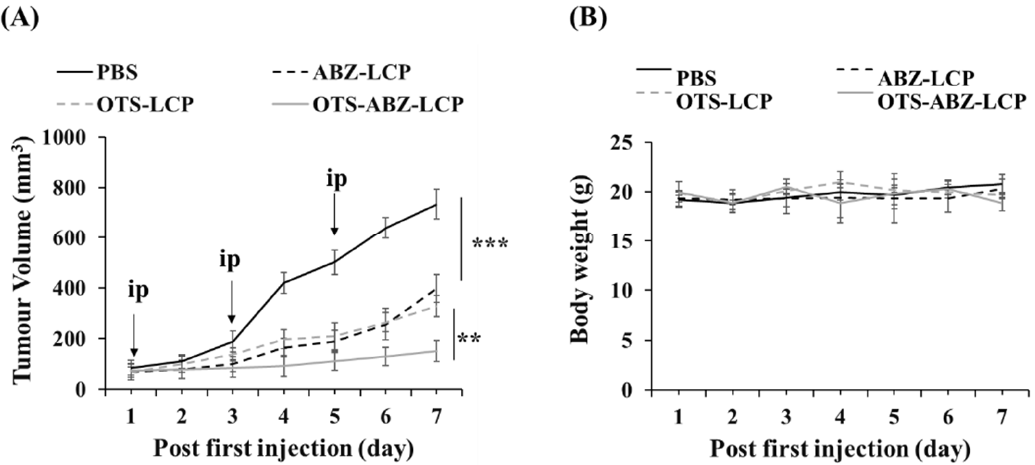
Figure 5. Enhanced tumour growth inhibition by co-delivery. ( A ) Tumour growth profile reflecting in vivo antitumour effect of ABZ-LCP, OTS-LCP and OTS-ABZ-LCP NPs (equivalent amount of 5 mg/kg albendazole and 2 mg/kg OTS) intraperitoneally injected 3 times every 2 days in the B16F0-bearing mouse model, compared to that of PBS injection; and ( B ) the average body weight treated with four formulations. Data are presented as mean ± SEM (n = 3–5).